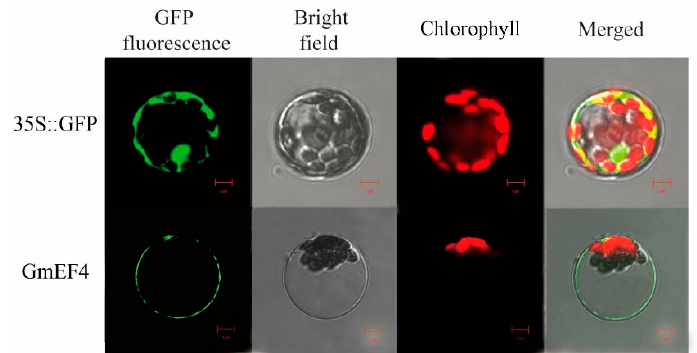
Figure 4. Localization of GmEF4 protein in Arabidopsis protoplasts. The construct was transferred into Arabidopsis protoplasts and the subcellular localization of the GFP expression was observed in cell membrane. Images were observed under a laser scanning confocal microscope. Bar = 5 µ m.